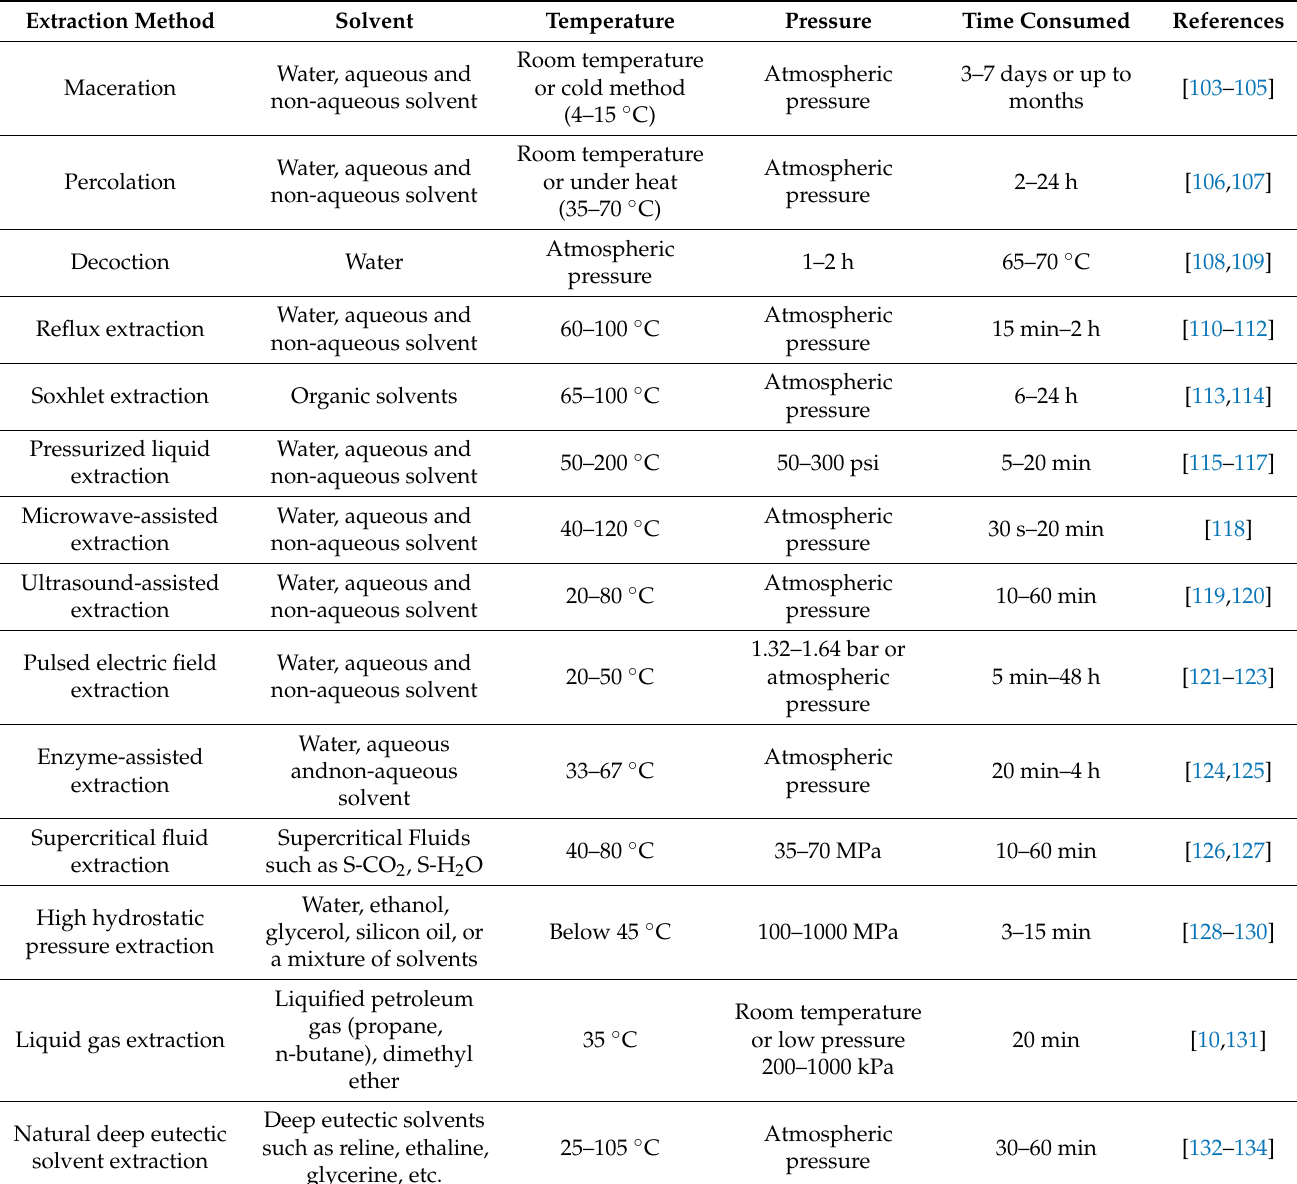
Table 2. The optimized conditions for the extraction of phytochemicals using various extraction